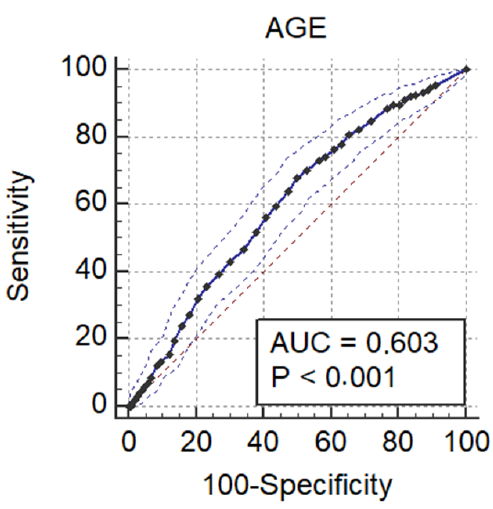
Figure 1. ROC analysis for age in detecting ADR.